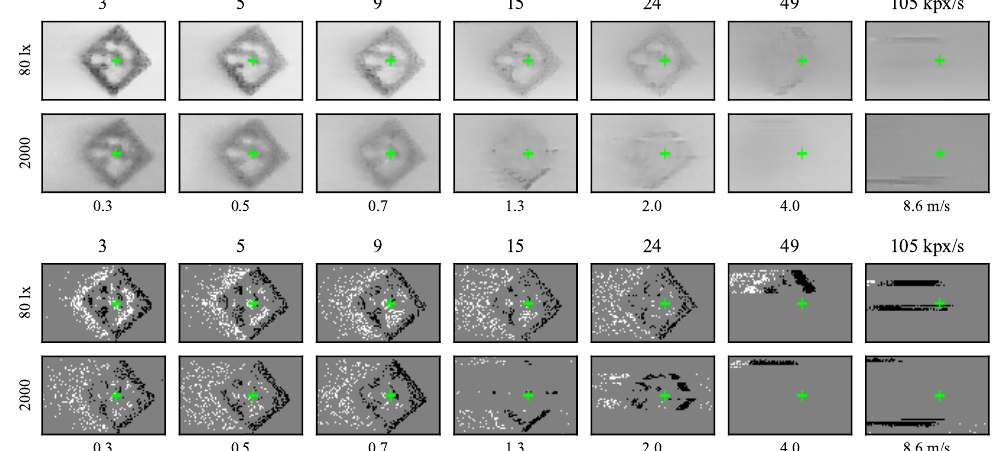
Figure 13. Sample reconstructed intensity and event marker images from the DVS240 sensor. The im- ages are shown for two illuminance levels at the sensor plane and seven image ( top )/metric ( bottom ) speeds. The green crosses indicate the ground truth position of the marker